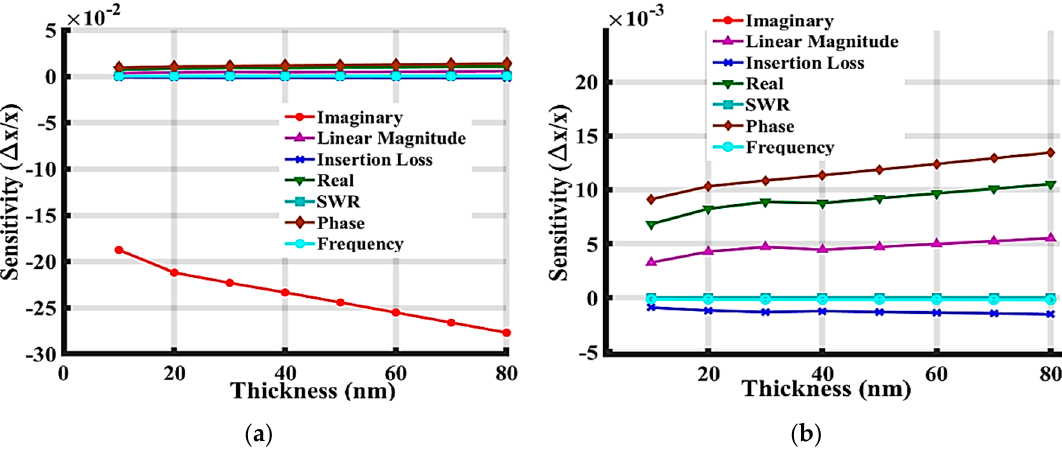
Figure 16. Simulation results of the SAW device with a 300 nm ZnO layer and an extra coating IrO 2 layer of varied thickness from 10nm to 80nm. ( a ) Full view of the plot, and ( b ) zoomed figure without Imaginary data.